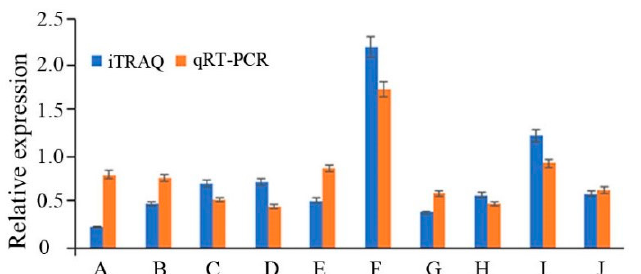
Figure 6. Comparative analysis of RNA and protein levels of differentially expressed proteins. A . sterol C-24 reductase (ERG4), B . 40S ribosomal protein S8, C . translation initiation factor 1A, D . zinc finger, E . tubulin alpha chain, F . acyl-CoA N-acyltransferase, G . nicotinamide adenine dinucleotide (NADH) ubiquinone oxidoreductase, H . flavin adenine dinucleotide (FAD)-dependent pyridine nucleotide-disulfide oxidoreductase, I . ATPase P-type Mg / Cd / Cu / Zn / Na / Ca / Na / H-transporter, J . serine / threonine-protein phosphatase.